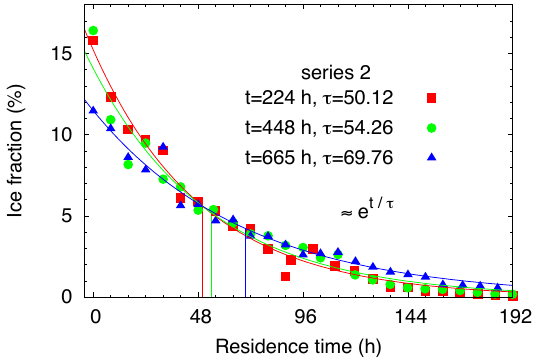
Fig. 7. Probability distribution of ice residence times at the same three time points shown in Fig. 6. Symbols represent the mea- sured data, while the curves are fitted exponential functions (Eq. 7, correlation coefficient r 2 > 0 . 95 for all series ) . The e -folding time τ , shown as a vertical line for each curve, slowly increases over time, but is always only a small fraction of the total experiment du- ration.